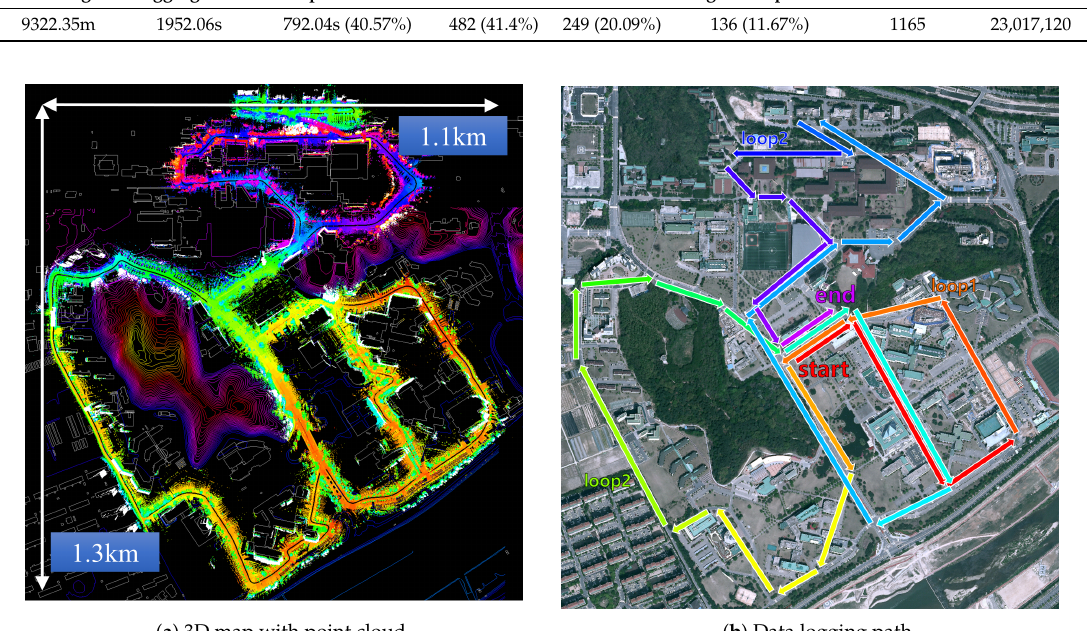
Figure 12. 3D mapping result and data logging path. ( a ) 3D map result represented by pseudo-colored point cloud in digital map background. Nodes are color-coded by height varying from red (low) to purple (high). ( b ) Illustration of data logging path performed in the experiments. Connection of the trajectory represented by color shift from red (start) to purple (end). There are three circular paths covering the eastern, the western, and the northern part of the